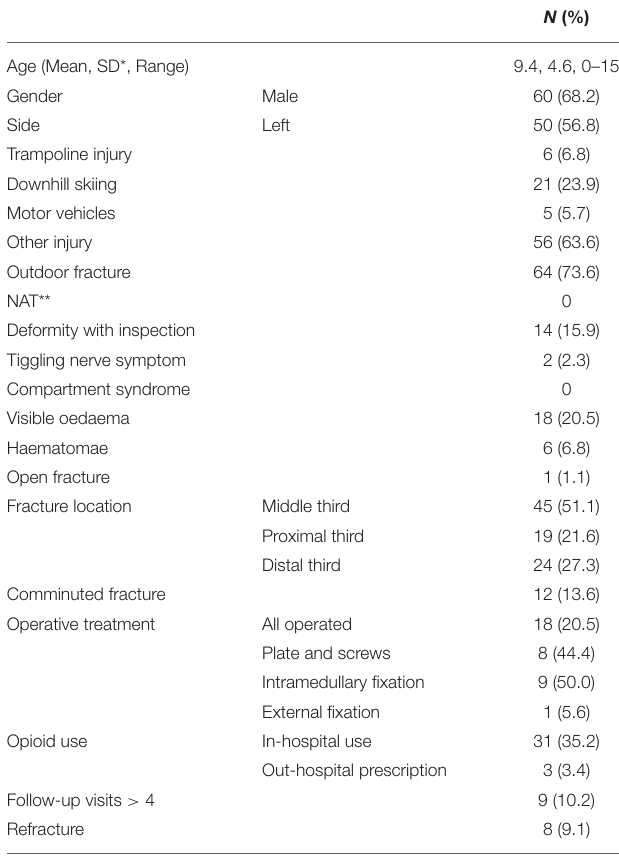
TABLE 1 | The background characteristics of the study cases and the primary findings of the